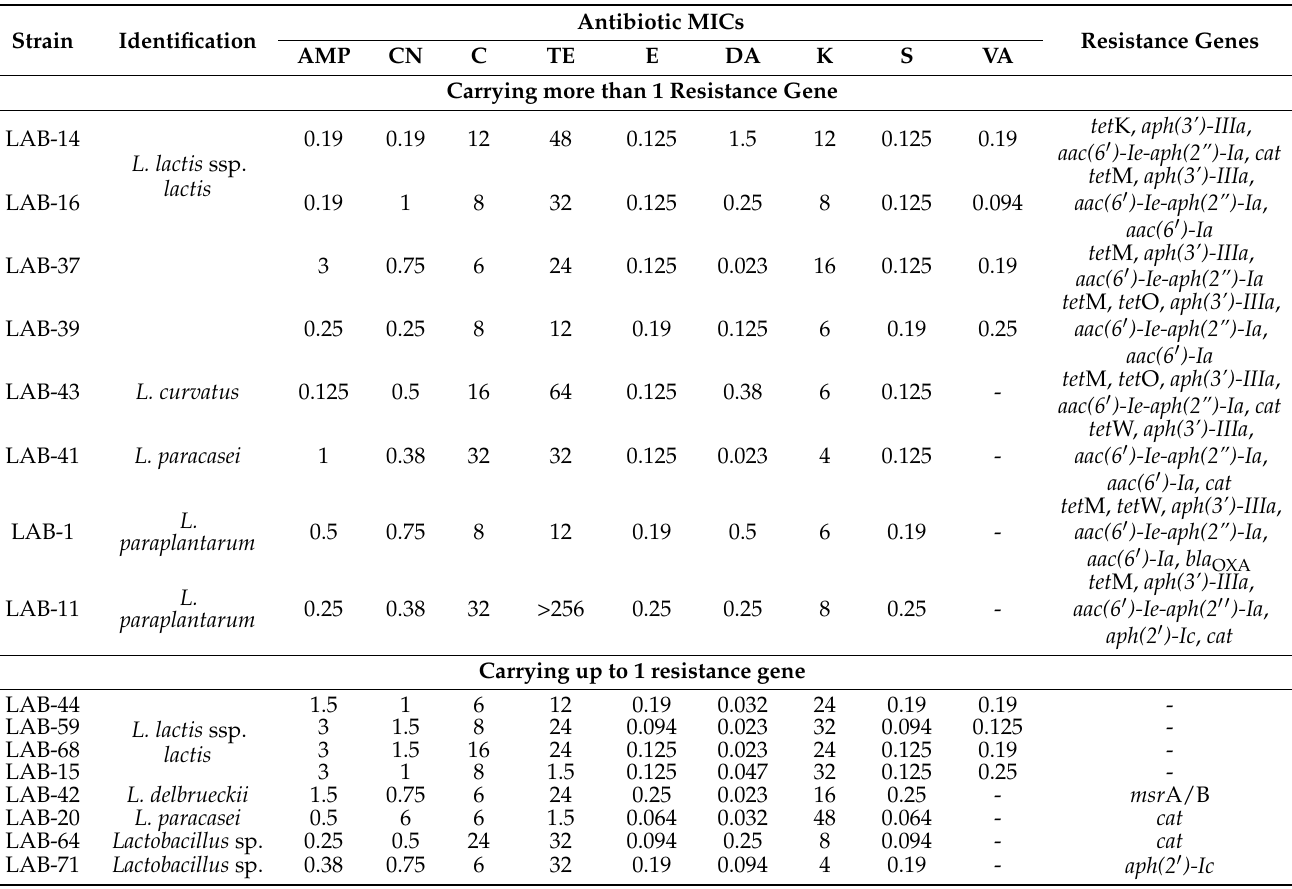
Table 1. Strains used in the